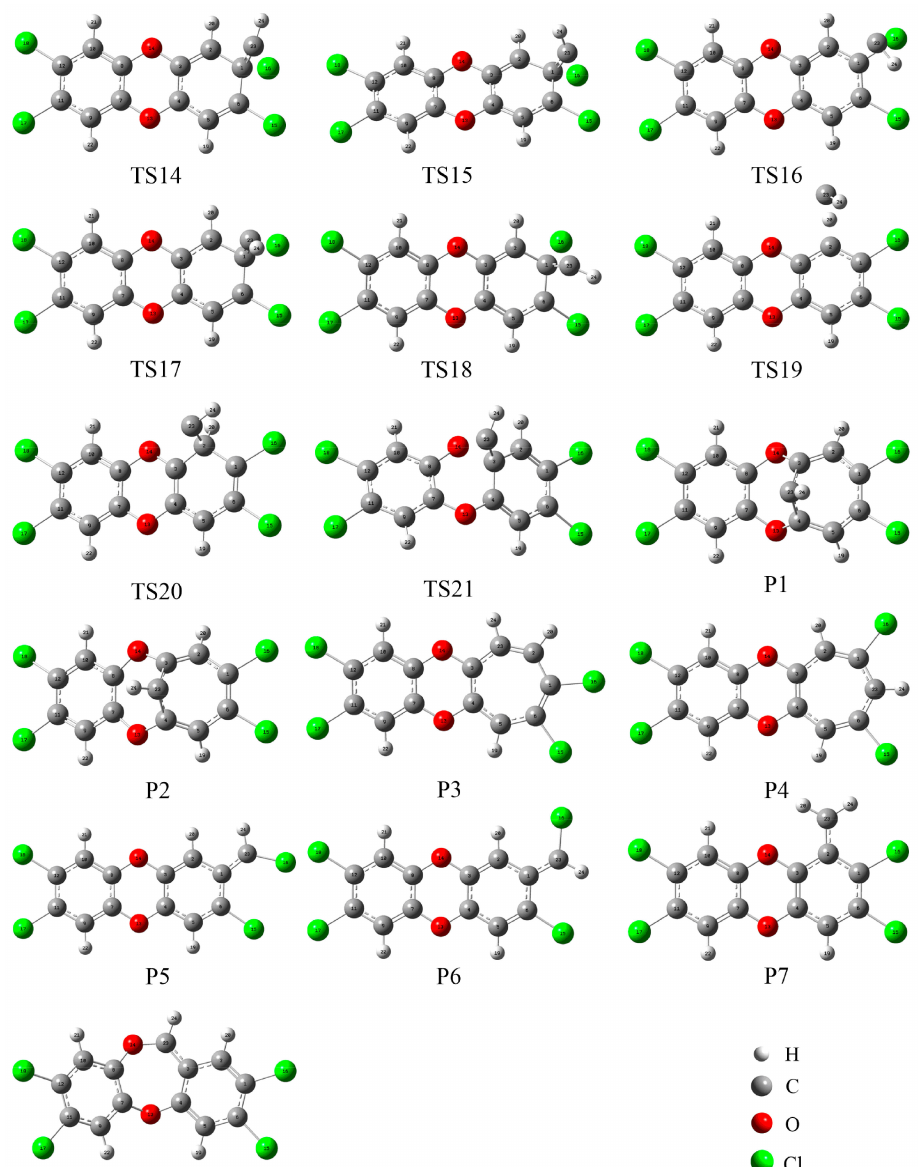
Figure 2. Optimized initial intermediates (IM), transition states (TS), and products in all the reaction pathways. The Cartesian coordinates of them have been given in Supporting Information for